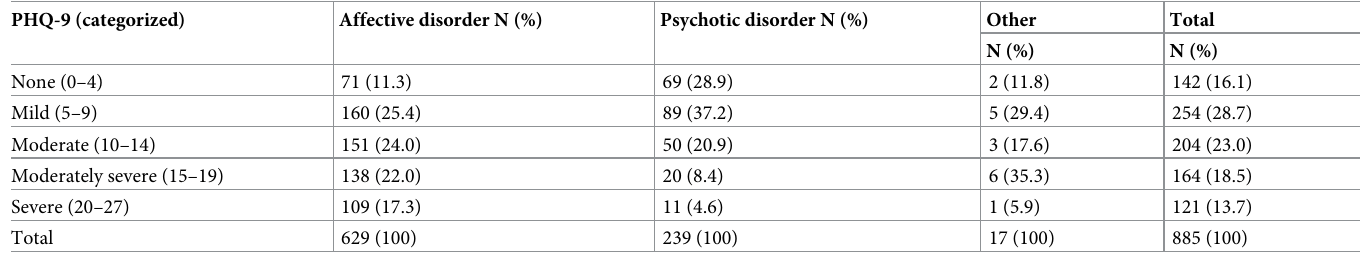
Table 5. Association between PHQ-9 (as categorized) and type of mental disorder. PHQ-9